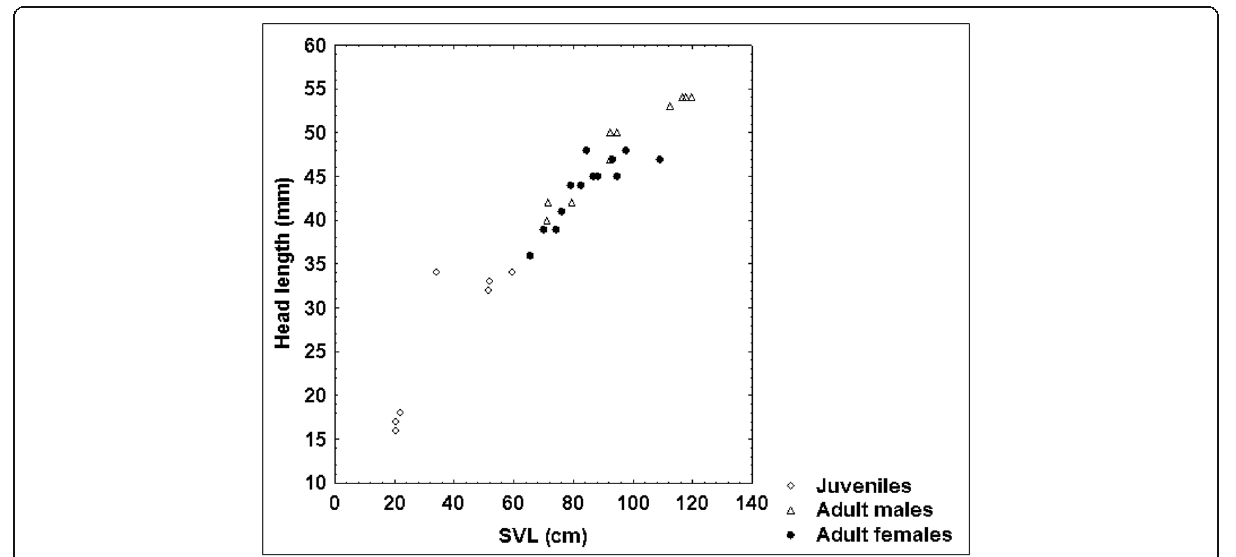
Fig. 10 Relationship between SVL and HL in 32 blunt-nosed vipers from Cyprus: R = 0.97